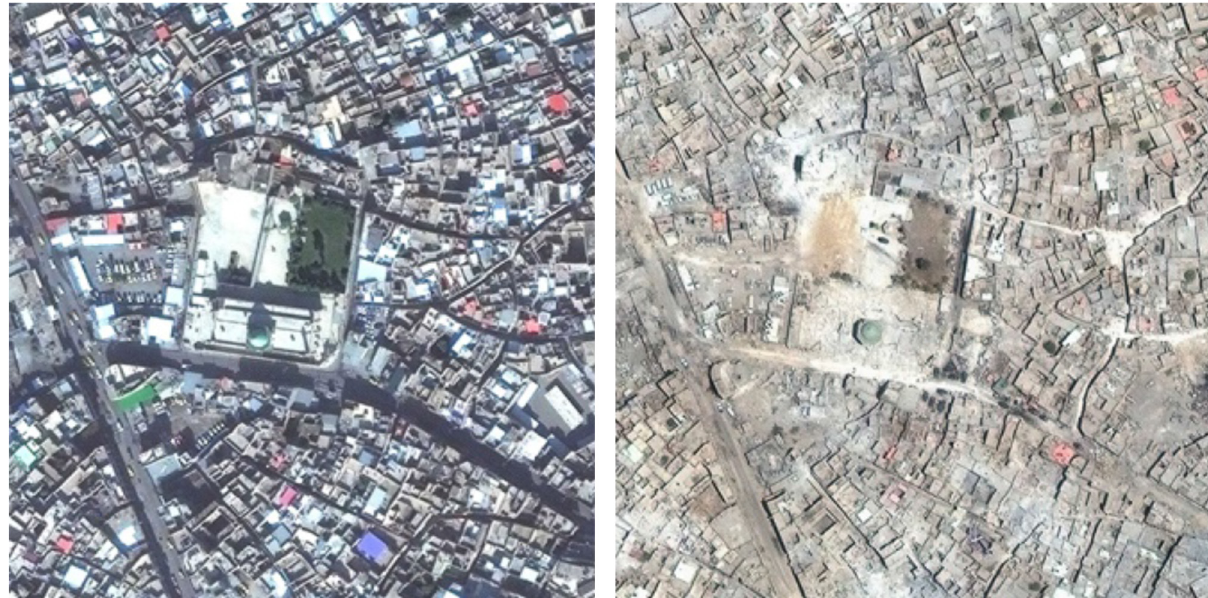
Fig. 3. Satellite picture showing Al Nuri Mosque area with the surrounding residential buildings before (in the left) and after (right) the strikes [left google maps, right: earth explorer].